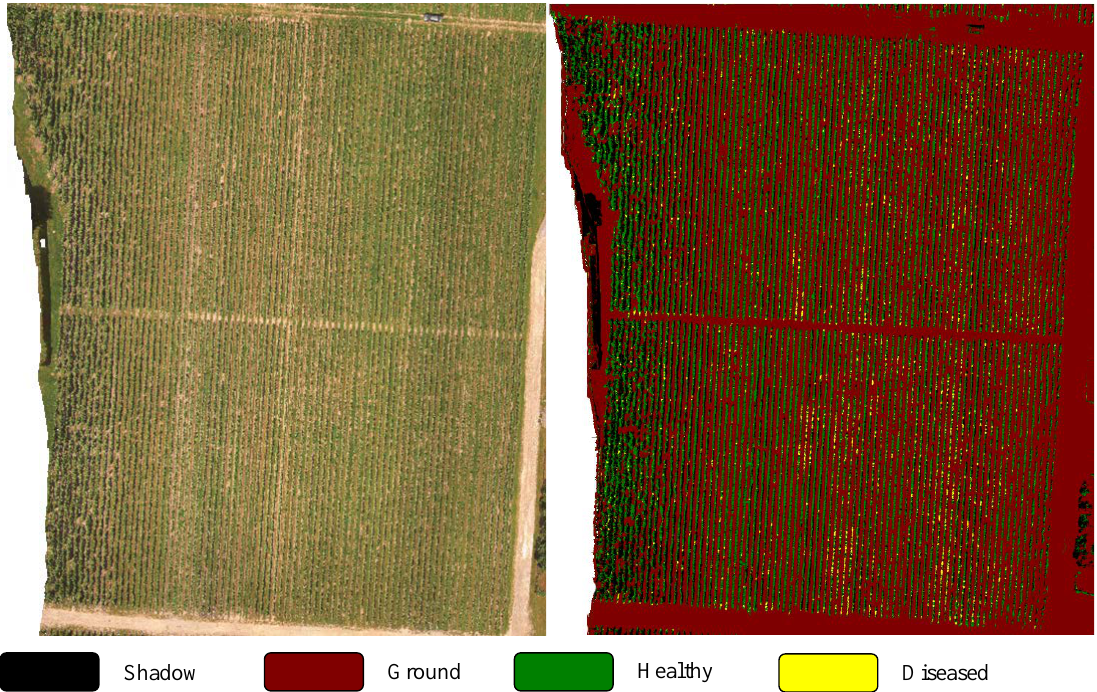
Figure 9. Qualitative result of VddNet on a parcel partially contaminated with mildew and with green ground. The visible orthophoto of the healthy parcel is in the left side, and its disease map in the right